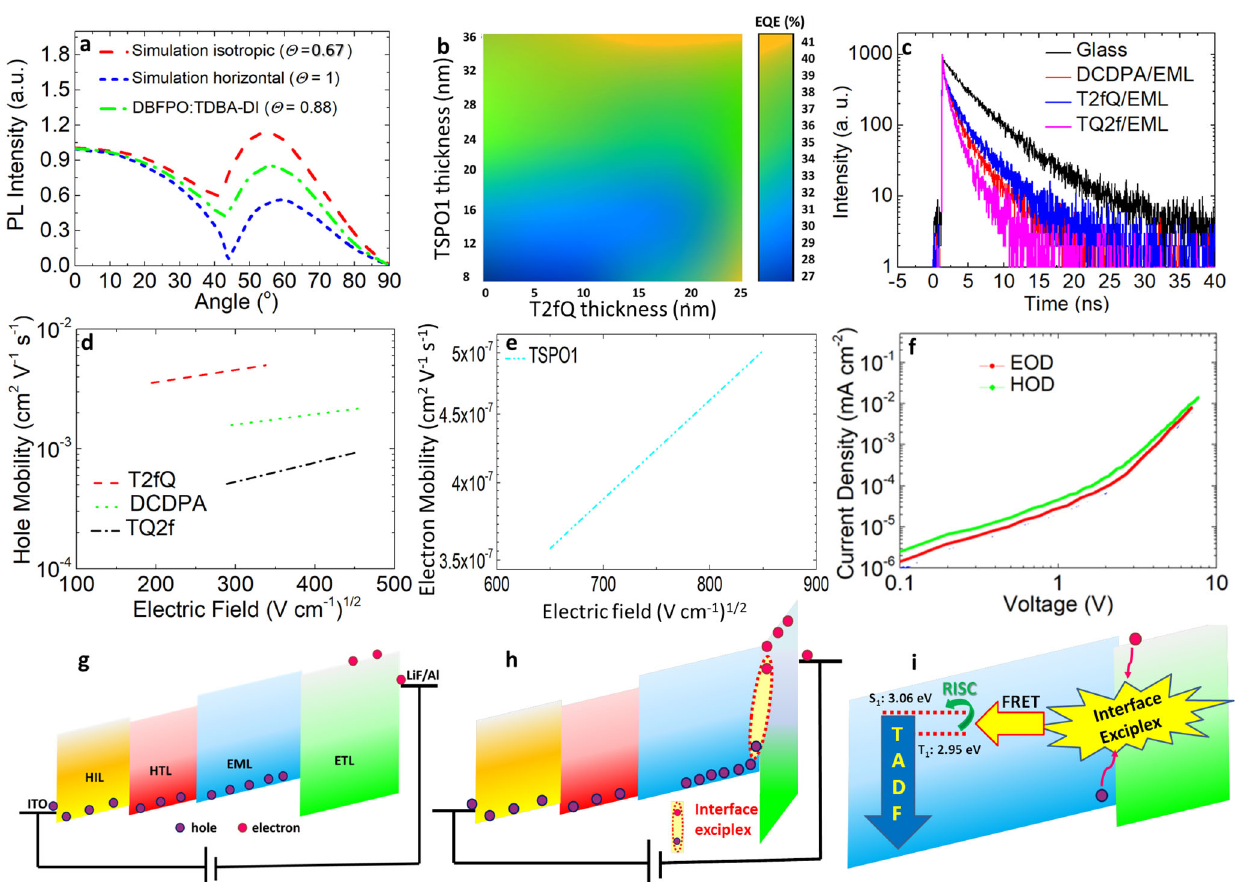
Fig. 4 Proposed operation mechanism. a Dependence of polarized PL intensity on the emission angle and b simulations for the thickness optimization of TSPO1 and T2fQ ETM and HTM. c TRPL decay curves of the EML on glass, DCPPA, T2fQ, and TQ2f fi lms. d Variation of hole mobility vs. the applied fi eld for the three different HTMs used in this study. e Variation of electron mobility on the applied fi eld of the TSPO1 ETM. f Current densities measured in hole-only (ITO/NPD/TQ2f/DBFPO 20%-TDBA-DI/NPD/Al) and electron-only (ITO/TSPO1/DBFPO 20%-TDBA-DI/TSPO1/LiF/Al) devices. Schematic response of an ITO/NPD/T2fQ/EML/ETL/LiF/Al device under forward applied bias. g The electric fi eld (slope of the energy levels) is evenly distributed across the device. Holes and electrons are injected from the anode and cathode contact, respectively, and transported through the HTL and ETL towards the EML. Due to the large difference in hole and electron mobilities of the HTM and ETM, respectively, holes are reaching the EML before electrons are transported within the ETL. h , i Holes reaching and start building up at the EML/ETL interface screen the electric fi eld to the ETL. The redistribution of the electric fi eld into the ETL accelerates electron injection/transport and electrons reach the EML/ETL interface where they subsequently form interfacial exciplexes with holes in the DBFPO layer. Interface exciplex con fi nes excitons and transfers them to the